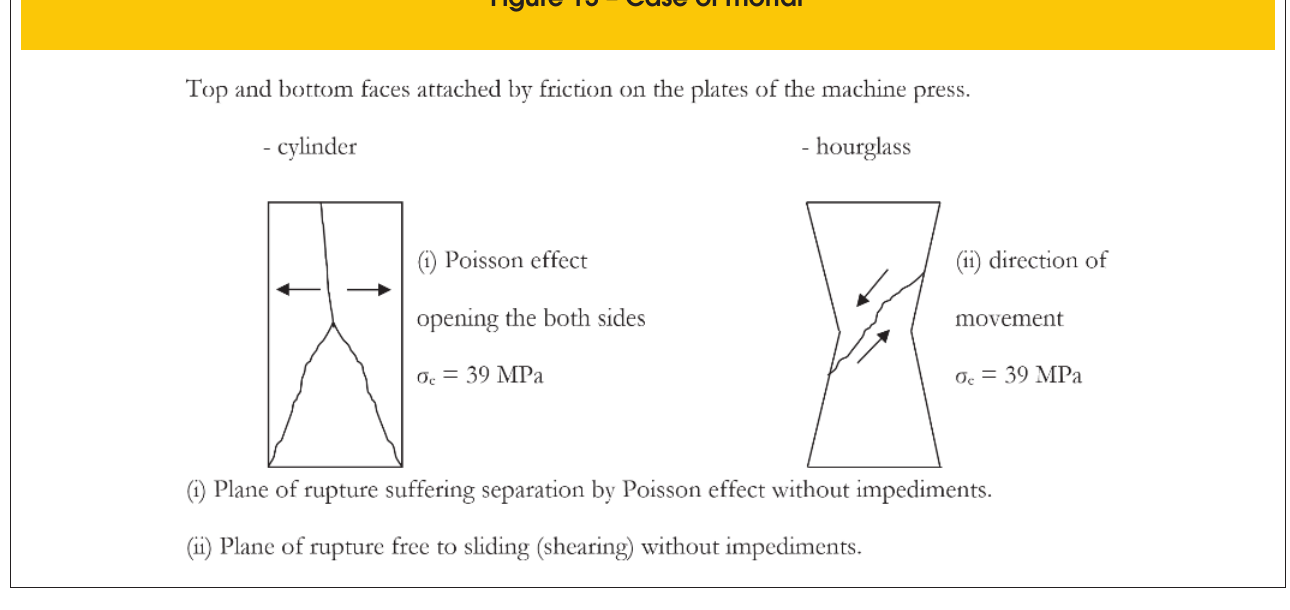
Figure 13 – Case of mortar